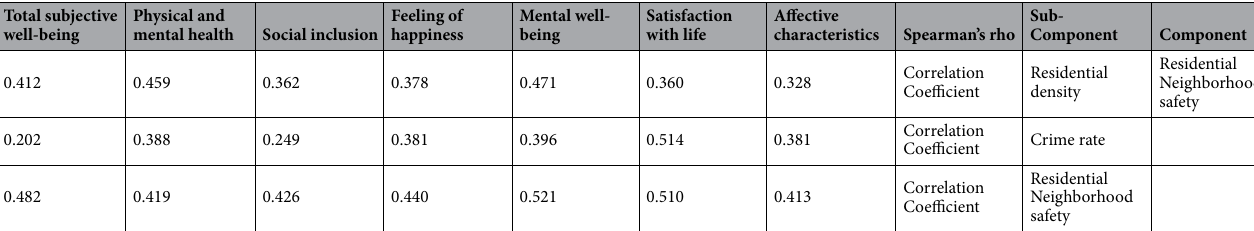
Table 7. The correlation of residential neighborhood safety and its sub-components with the constituent components of citizens’ subjective well-being.